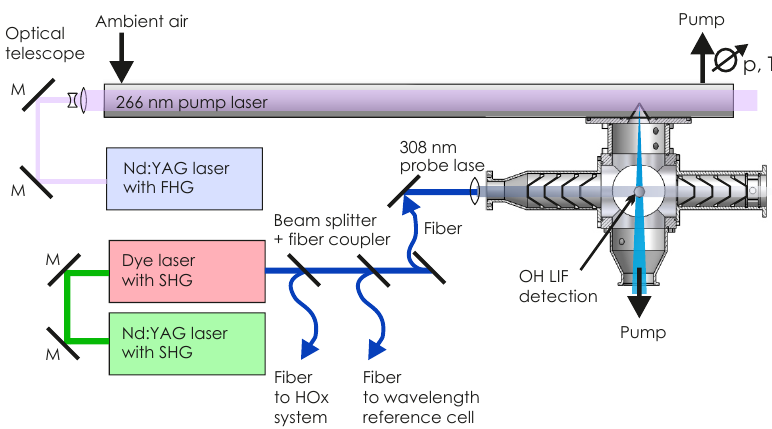
Figure 1. Schematics of the Jülich OH reactivity instrument (M: turning mirror). Ambient air is sampled into a flow tube. A small part of the air is drawn into the OH detection cell that is operated at a pressure of 4hPa. High OH concentrations are produced by flash photolysis of ozone at 266nm at a low frequency of 1 to 2Hz. The OH concentration is probed at a high frequency of 8.5kHz so that the loss of OH radicals due to their reaction with OH reactants in the ambient air can be